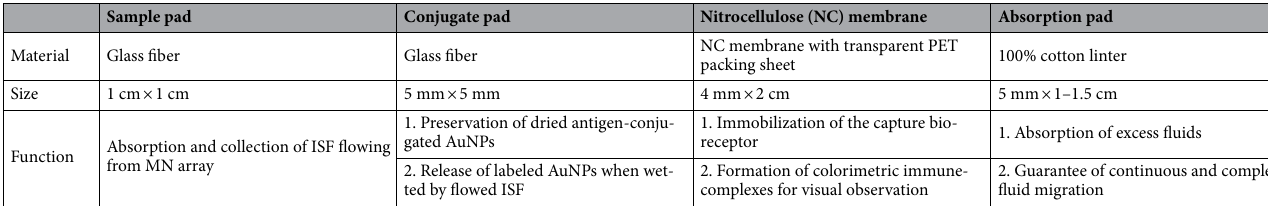
Table 1. Properties and design of each “paper” component used in the immunochromatographic